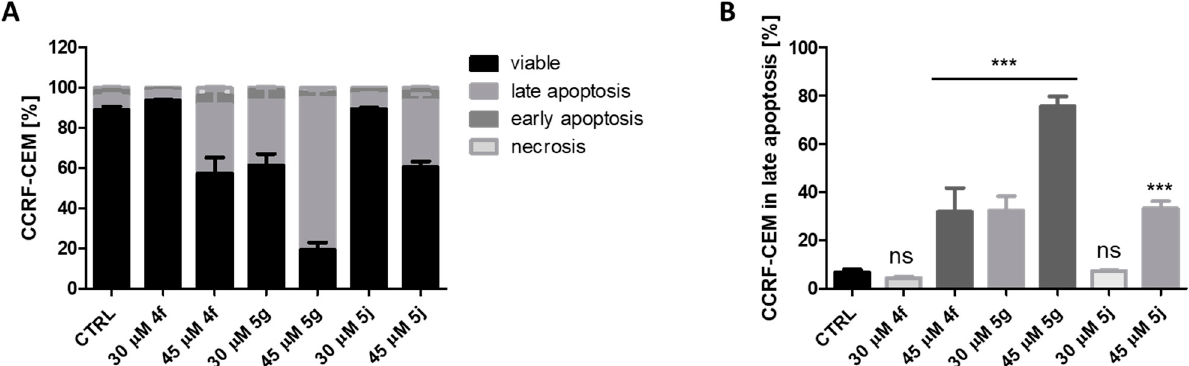
Figure 2. Effect of compounds 4f , 5g , and 5j on the progression of apoptosis/necrosis in CCRF-CEM. Percentage of viable, early, and late apoptotic, and necrotic cells after 48 h of treatment with the tested compounds ( A ). Percentage of CCRF-CEM cells in late apoptosis ( B ). Cells were stained with annexin V-FITC and PI (propidium iodide). Flow cytometry analyses were run on FACSCanto II flow cytometer (BD Biosciences, San Diego, CA, USA) and analysed using BD FACSDiva software. Graphs represent mean values ± s.e.m. *** p < 0.001 relative to control; ns—not significant. Statistical analysis for three to six independent replicates was performed using a one-way ANOVA analysis (GraphPad Software Inc., San Diego, CA, USA).